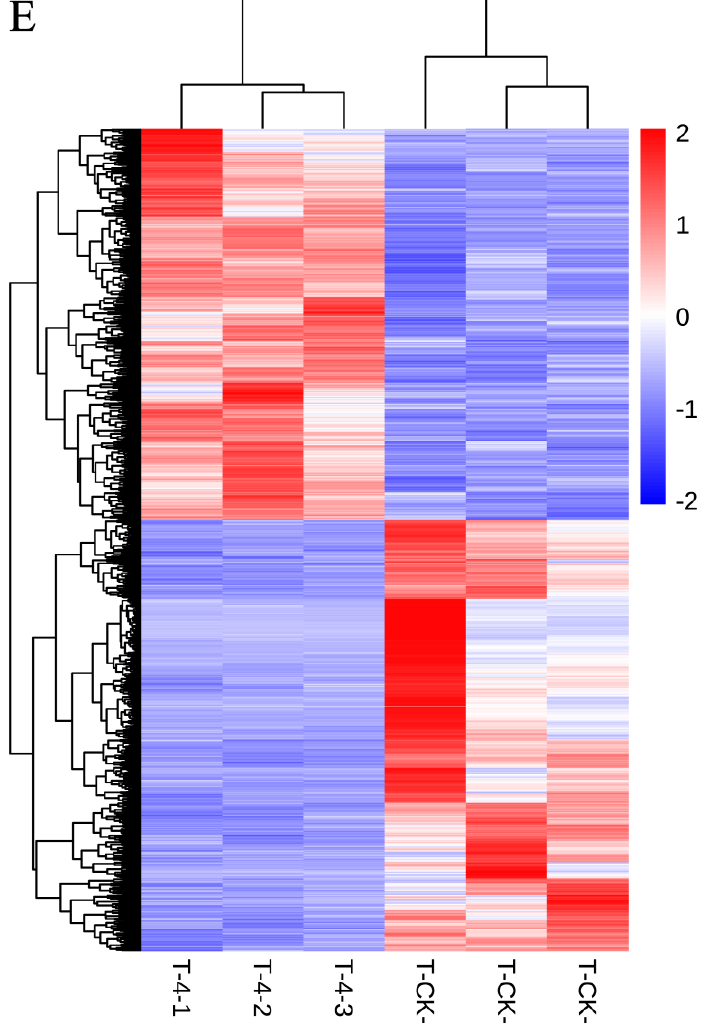
Figure 2. GO and KEGG enrichment analysis on the significant differential genes in T-4 vs. T-CK comparison. ( A , C ) Gene ontology enrichment analysis on up-regulated and down-regulated differential genes respectively in T-4 vs. T-CK comparison. DEGs were divided into biological process, cellular component and molecular function distinguished with the different adjusted P-value of each GO terms shown in vertical coordinate represented. ( B , D ) KEGG pathway enrichment analysis on up-regulated and down-regulated genes respectively upon T-4 treatment. ( E ) The expression profiles of all DEGs involved in the comparison of T-4 vs. T-CK. The red color displays up-regulated DEGs and blue color displays down-regulated DEGs in heatmap.